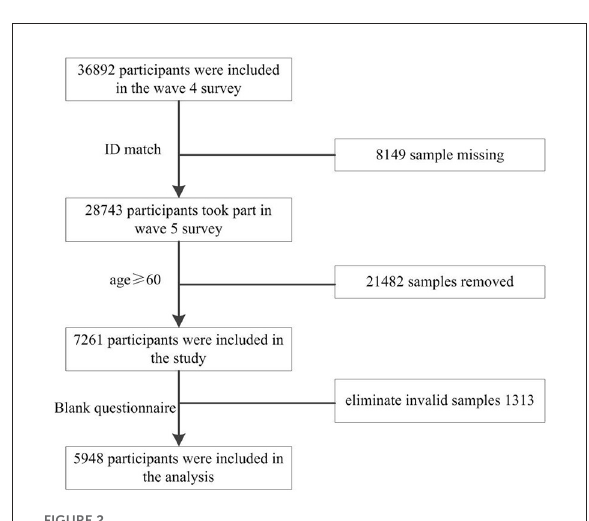
FIGURE2 Flow chart depicting participant inclusion and